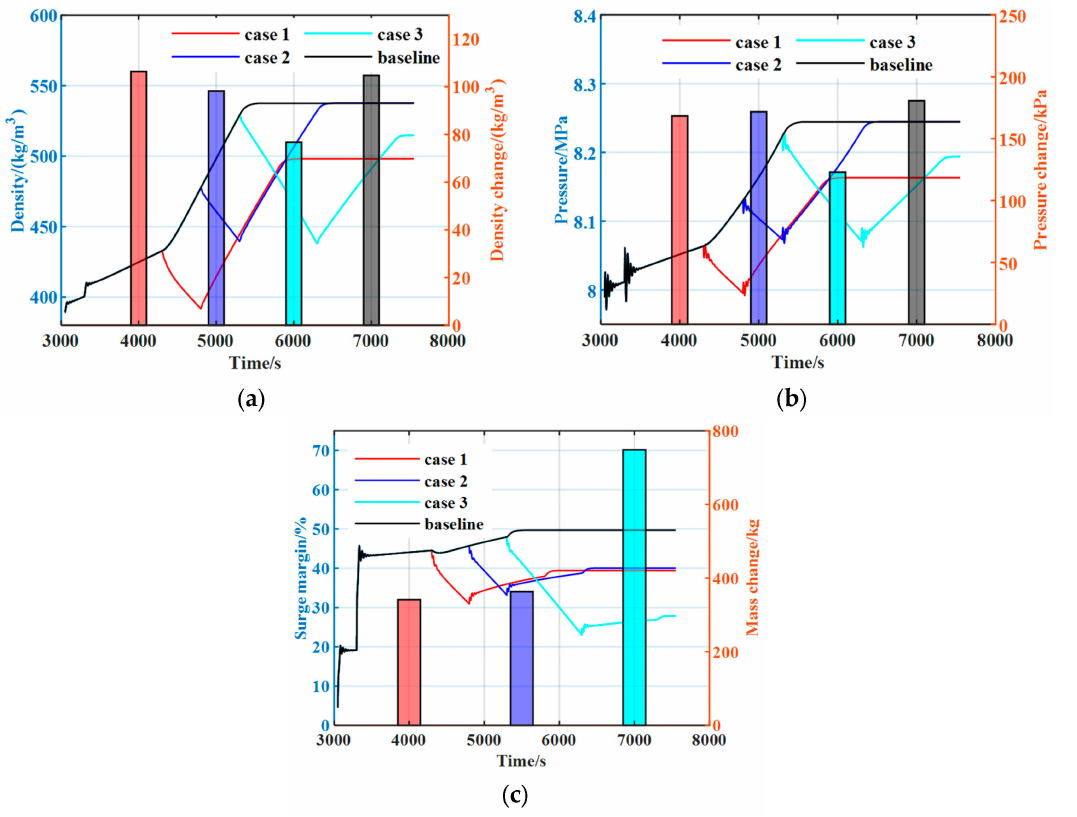
Figure 11. Comparison of CO 2 venting conditions and discharge amount: ( a ) buffer tank density comparison; ( b ) buffer tank pressure comparison; ( c ) system mass change and compressor surge margin